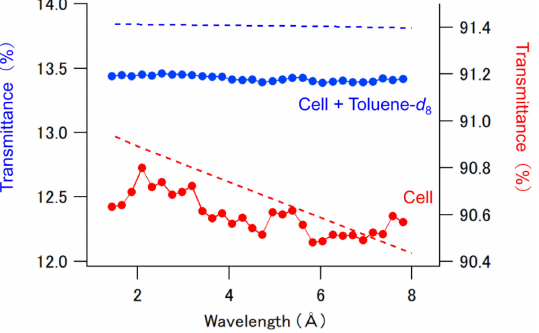
Figure 2. The transmittance dependence on the wavelength of the incident neutrons. The red circles are the transmittance of the sample cell and the blue circles are the transmittance of the toluene- d 8 including the sample cell. The dashed lines are the calculated transmittance values for each